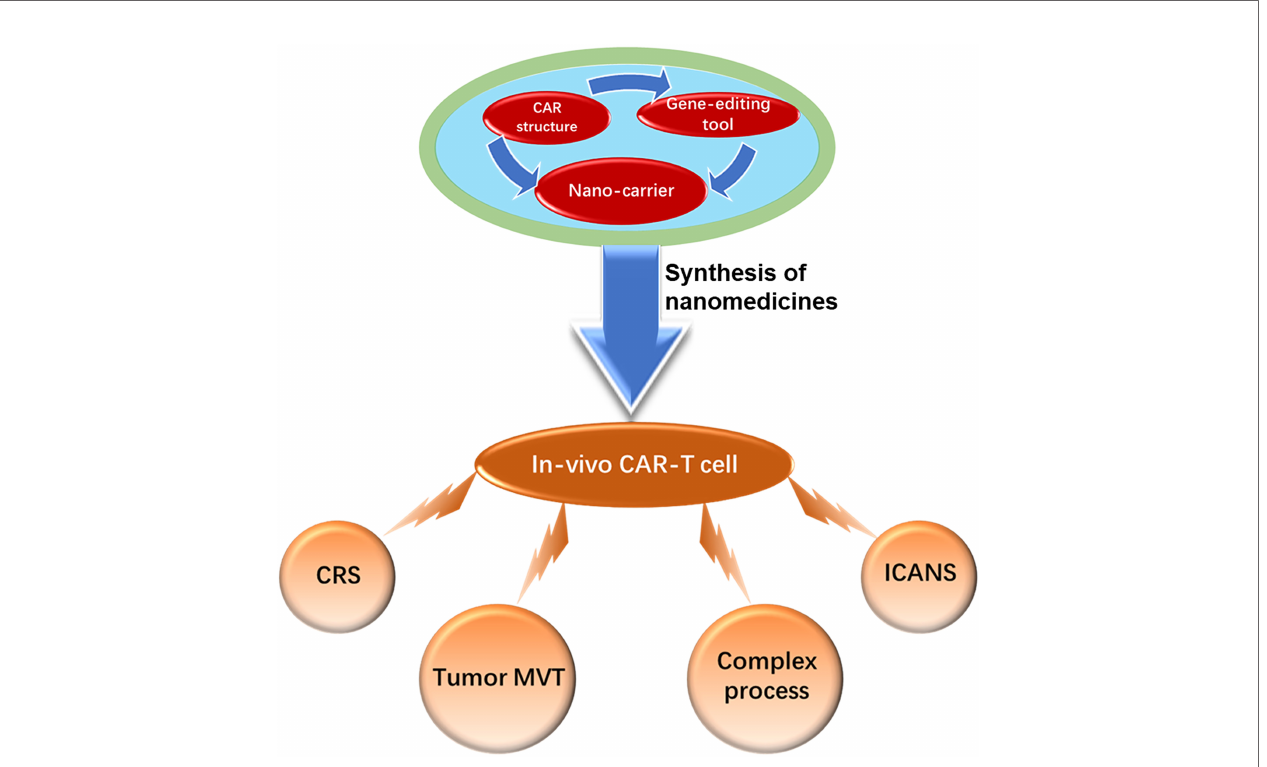
FIGURE 4 | Overcoming the barriers of cytokine release syndrome (CRS), immune effector cell-associated neurotoxicity syndrome (ICANS), tumor microenvironment (MVT), and complex process through in-vivo CAR-T cell induced by nanomedicines composed of nano-carrier loaded with the CAR structure or a gene-editing tool.